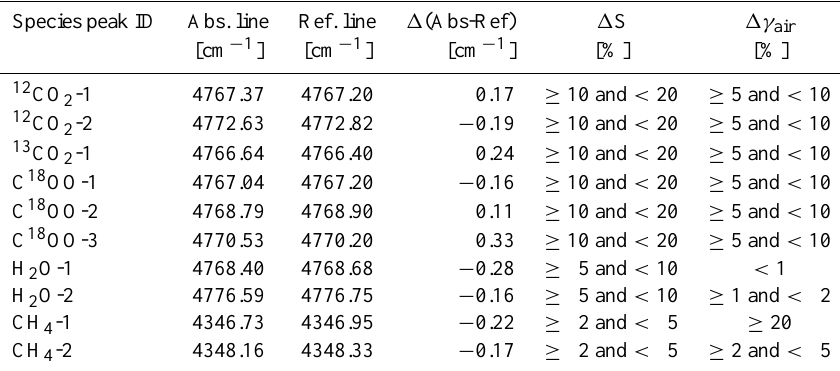
Table 4. Absorption line center frequencies and corresponding reference frequency allocations used in the retrieval, complemented by information on spectroscopic parameter uncertainties from HITRAN08 for the two most relevant line parameters, line intensity and air- broadened half width. Species peak ID Abs. line Ref.